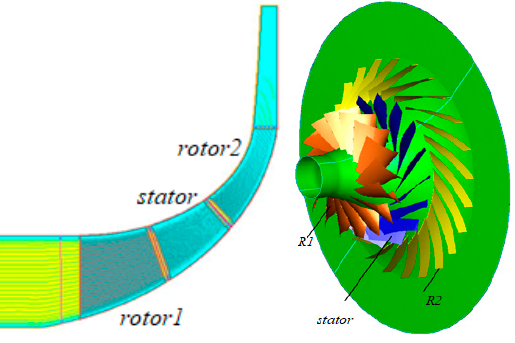
Figure 27. Novel 1.5 stage centrifugal compressor meridional view and 3D blade shape. Two rotating rows of blades are mounted on the same impeller disk, separated by a stator blade row attached to the casing. This arrangement allows for more turning of the flow due to the presence of the stator which allows the second rotor to be independent of the first rotor orientation as described by Muppana et al. [85,86] in collaboration with the authors. Muppana [85] also developed a low-fidelity meanline design tool for centrifugal compressors with the authors to obtain spanwise metal angle distribution at LE and